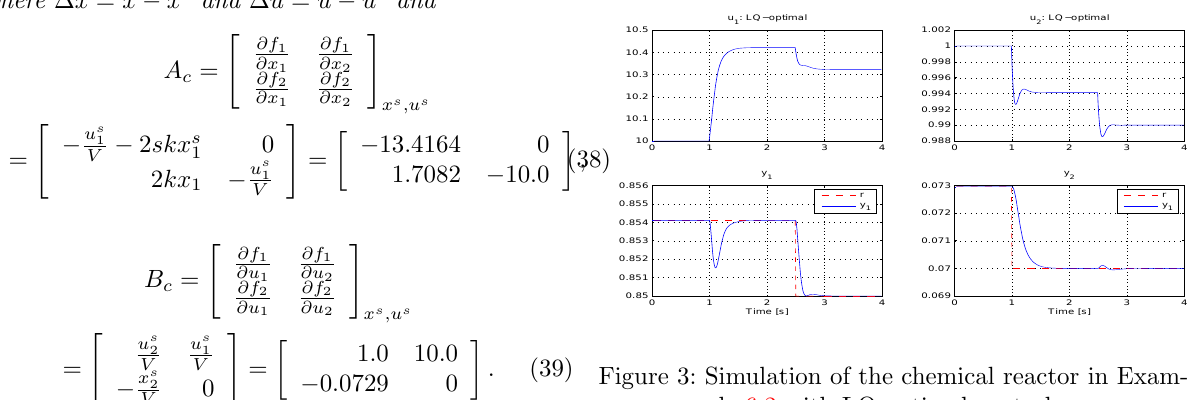
Figure 3: Simulation of the chemical reactor in